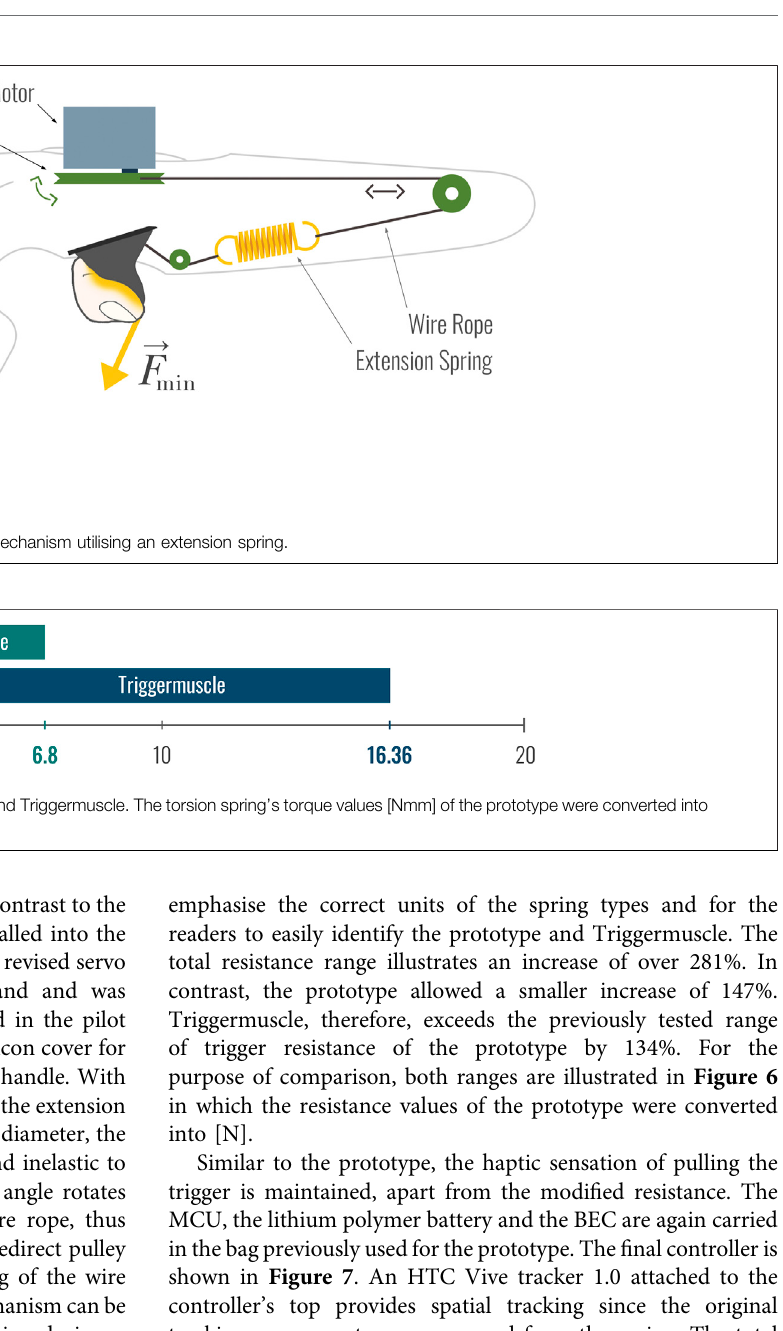
Frontiers in Virtual Reality |